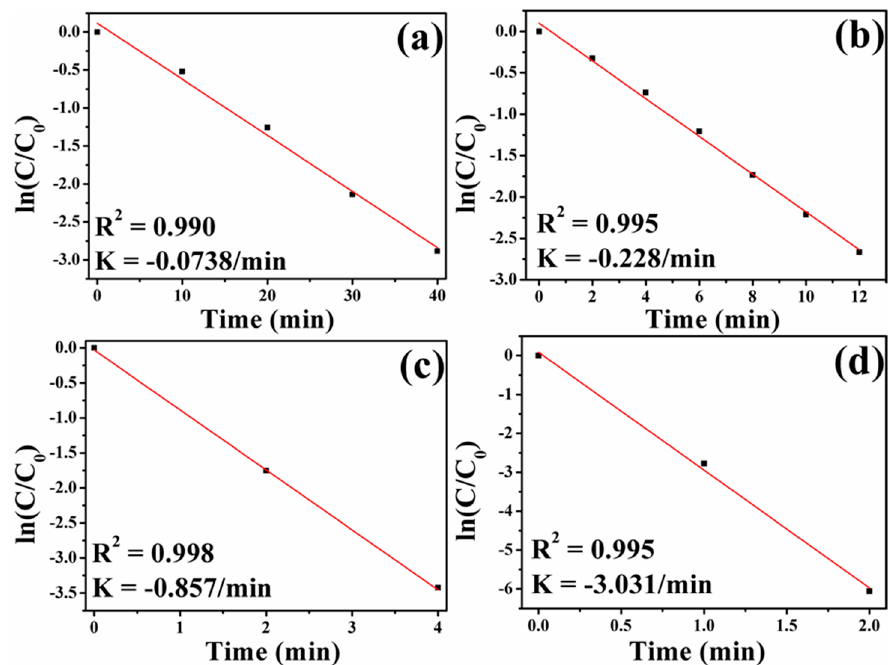
Figure 9. Plots of ln(C/C 0 ) against reaction time: Fe 3 O 4 -Au 5 mL ( a ), Fe 3 O 4 -Au 20 mL ( b ), Fe 3 O 4 -Au 40 mL ( c ) and Fe 3 O 4 -Au 60 mL ( d ).